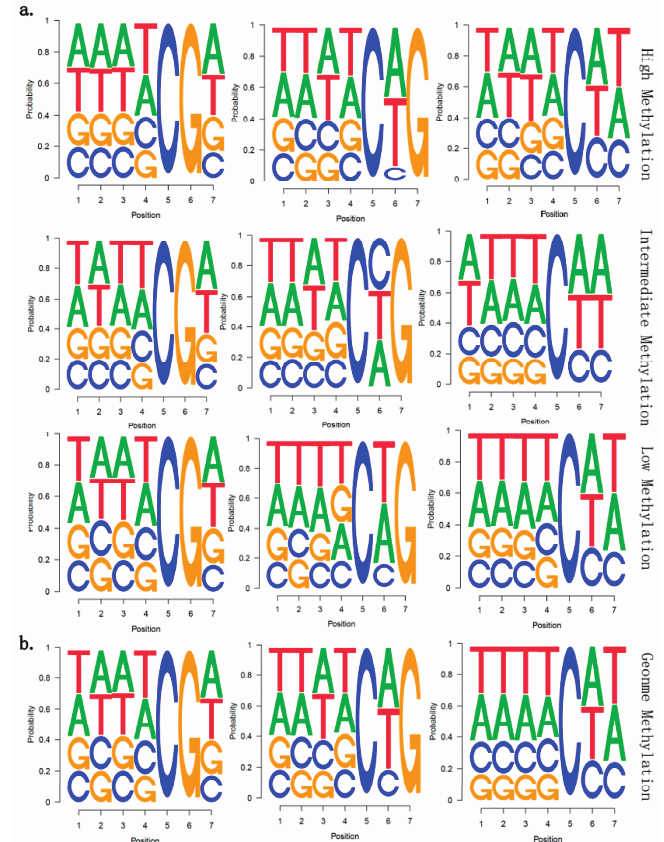
Figure 6. Sequence preferences for methylation in CG, CHG, and CHH contexts. ( a ) The mC site methylation level was divided into three groups: High Methylation (ML ≥ 0.8), Intermediate Methylation (0.2 < ML < 0.8) and Low Methylation (ML ≤ 0.2) for 7-mer sequences in which the methylated cytosine is in the fifth position; ( b ) all genomic7-mers in whole genome were analyzed. ML indicated methylation